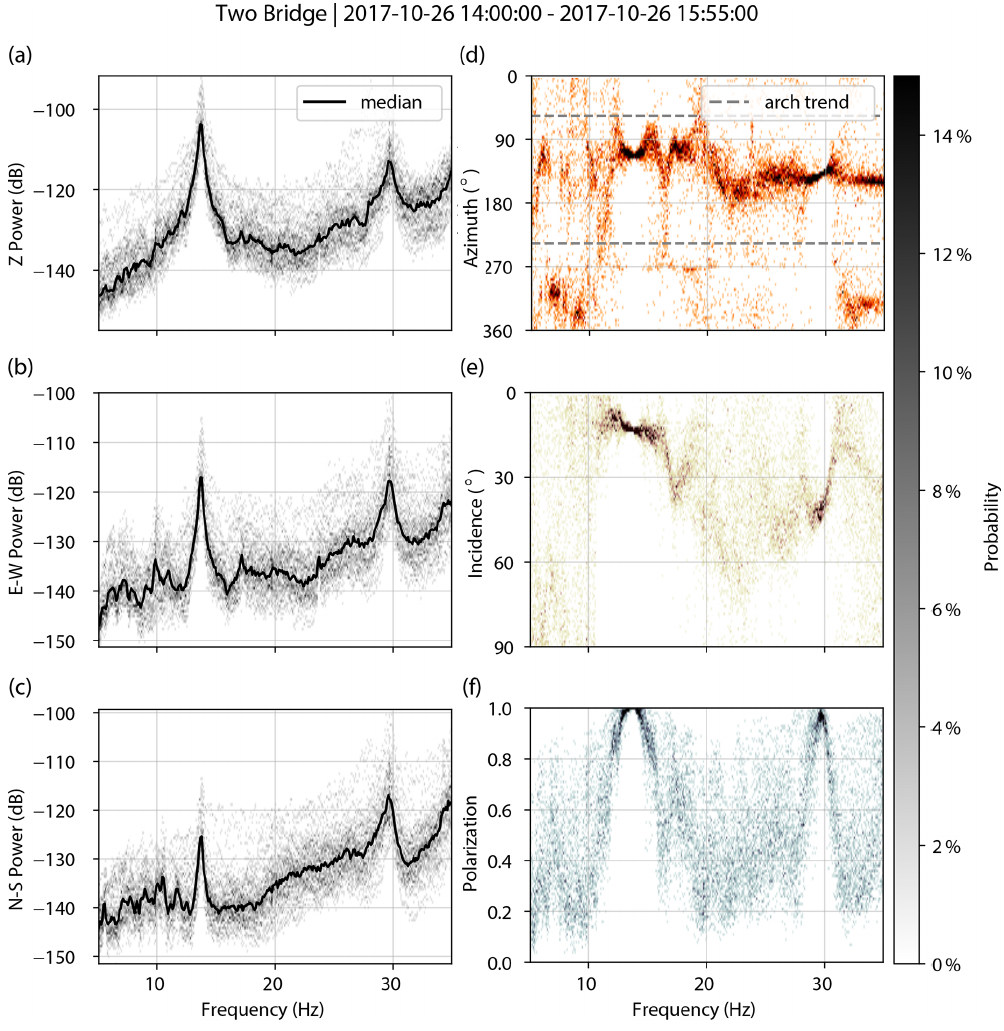
Figure A7. Two Bridge. PSDs for vertical (a) , east–west (b) , and north–south (c) components. Decibel powers are relative to 1m 2 s − 4 Hz − 1 . Polarization attributes of azimuth (d) , incidence (e) , and degree of polarization (f) .